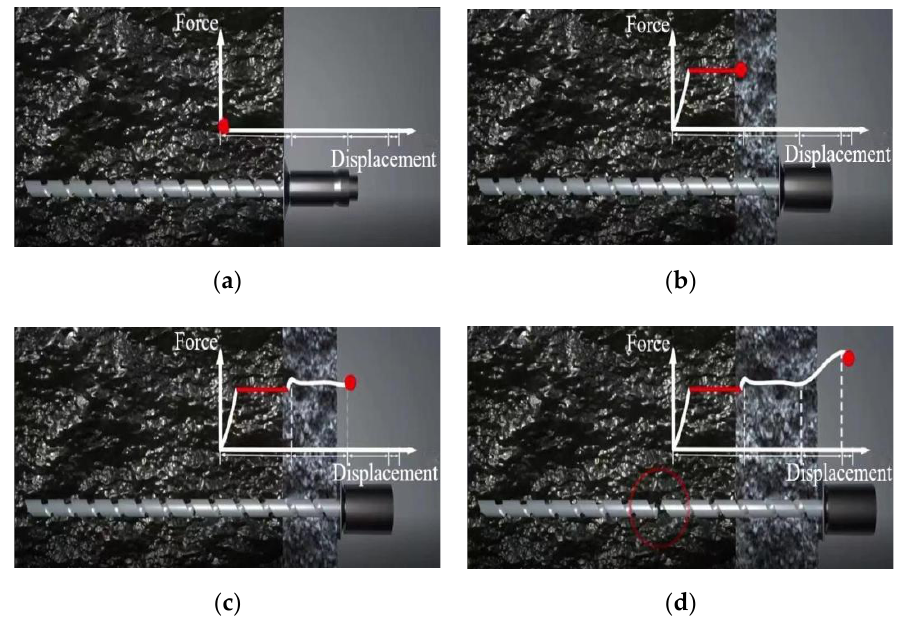
Figure 3. Deformation process of constant resistance energy-absorbing anti-scouring anchor rod by force, ( a ) initial stage ( b ) constant resistance deformation stage ( c ) yielding stage ( d ) strengthening and damage stage.